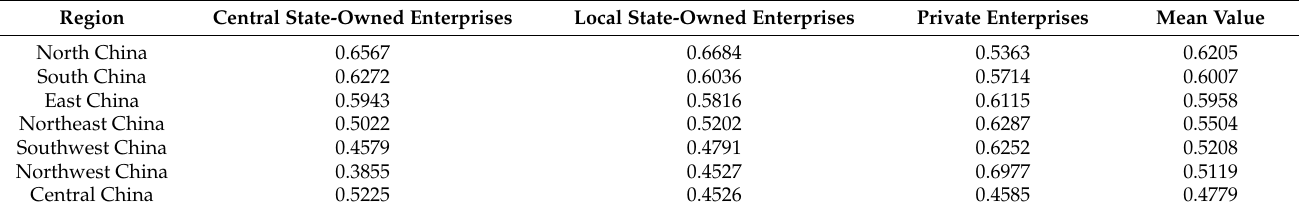
Table 5. Average TE of ownership enterprises by